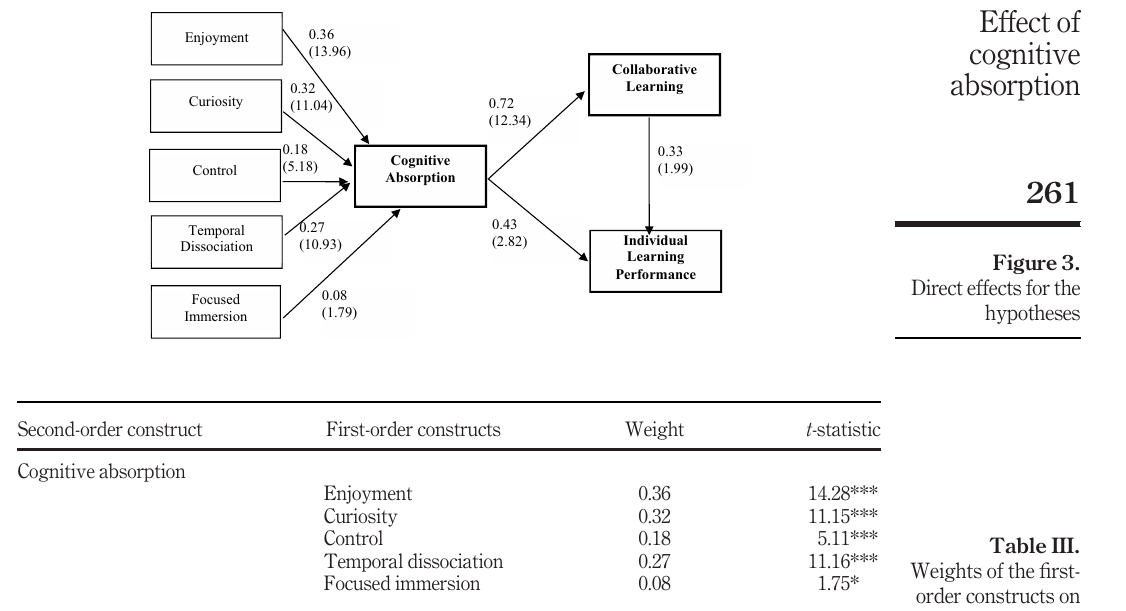
Table III. Weights of the fi rst- order constructs on